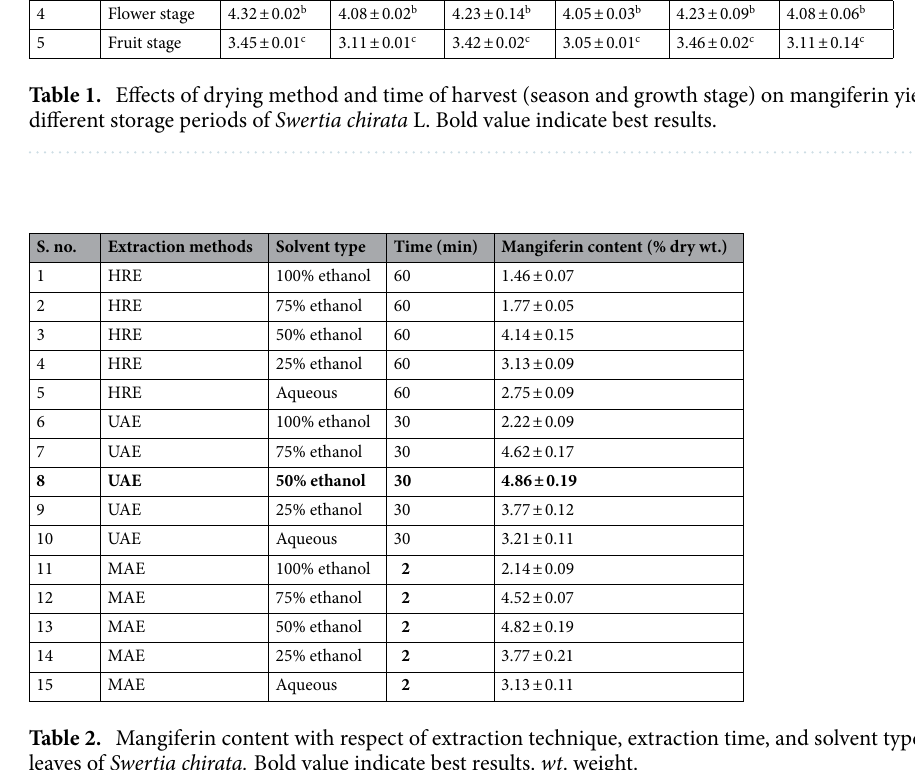
Table 2. Mangiferin content with respect of extraction technique, extraction time, and solvent types from leaves of Swertia chirata. Bold value indicate best results. wt . weight.